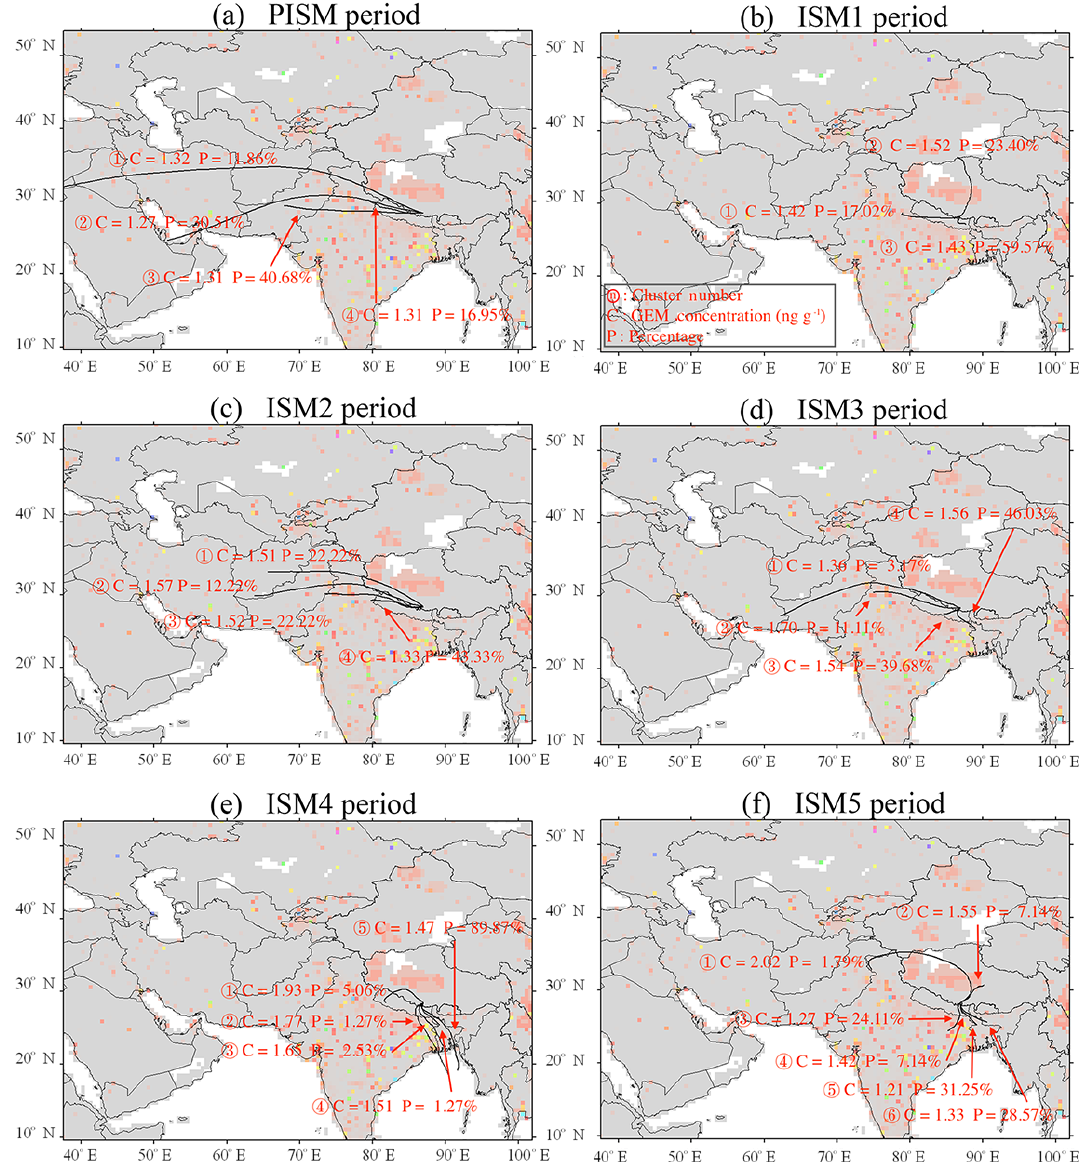
Figure 5. Clusters of the back trajectory analysis from the Qomolangma National Nature Preserve (QNNP) monitoring site during the pre- Indian summer monsoon (PISM) period and the five Indian summer monsoon (ISM) periods. The cluster statistics summarize the percentage of back trajectories for each cluster. The background shading represents the global Hg emissions from anthropogenic sources (AMAP/UNEP,